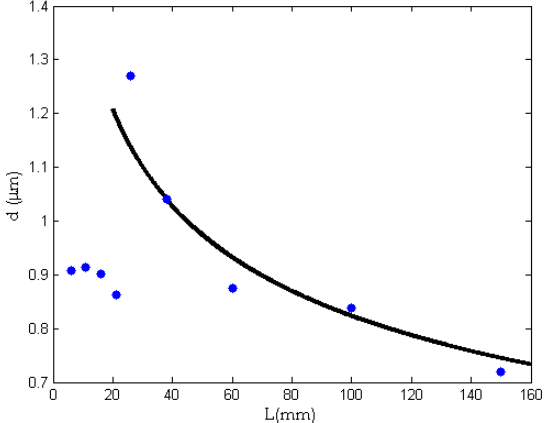
Figure 11. The relationship between needle length and pore size. Dots: experimental data; the continuous line: theoretical result by Equation (19).